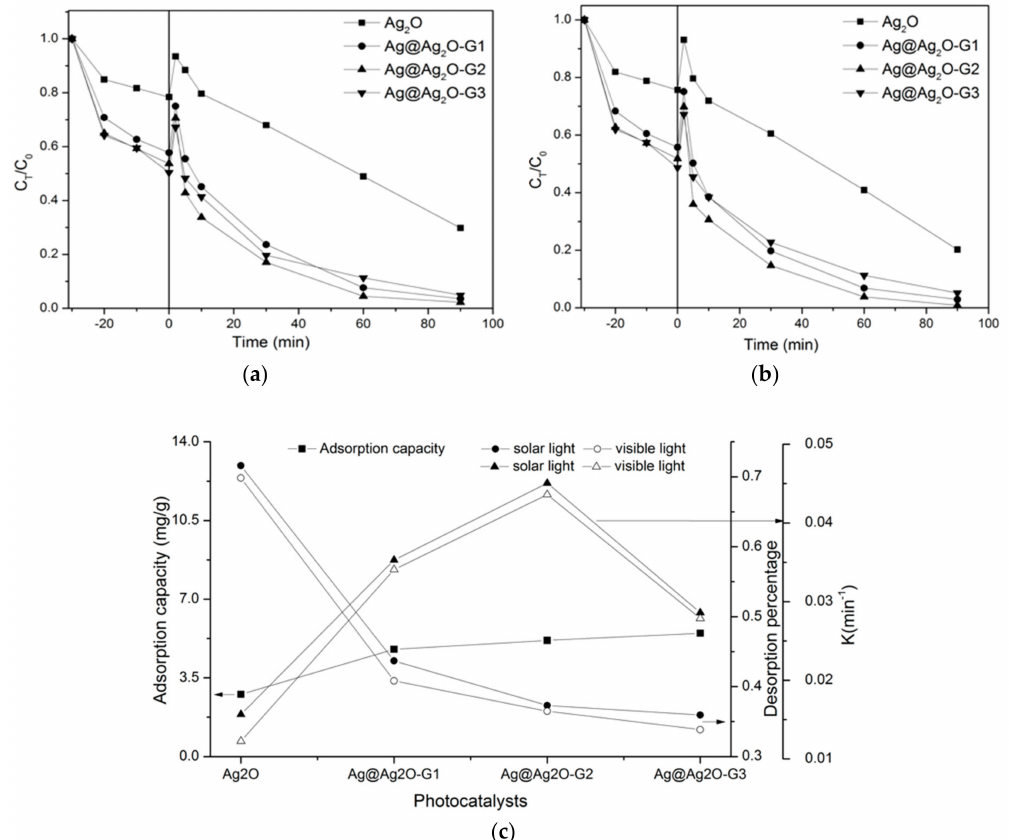
Figure 3. Adsorption abilities and photocatalytic activities of Ag 2 O, Ag@Ag 2 O-G1, Ag@Ag 2